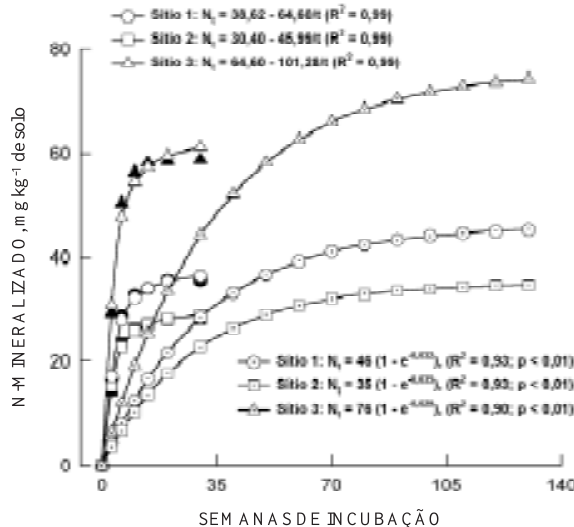
SEMANAS DE Figura 3. Dados experimentais de mineralização aeróbia de N dos sítios florestais 1, 2 e 3, e valores estimados pela equação N = N (1 – e -kt ), proposta t 0 por Stanford & Smith (1972), comparativamente = N – b/t. aos estimados pela equação N t 0